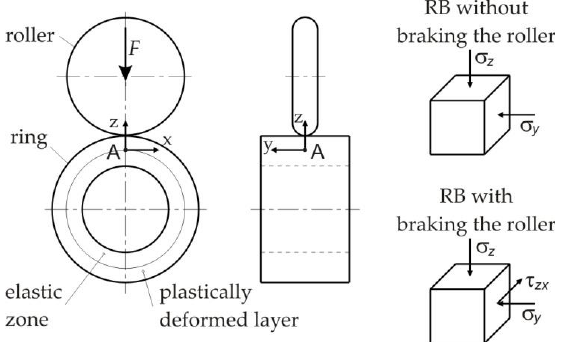
Figure 15. Stress tensor components for point A for variants of RB with and without braking the